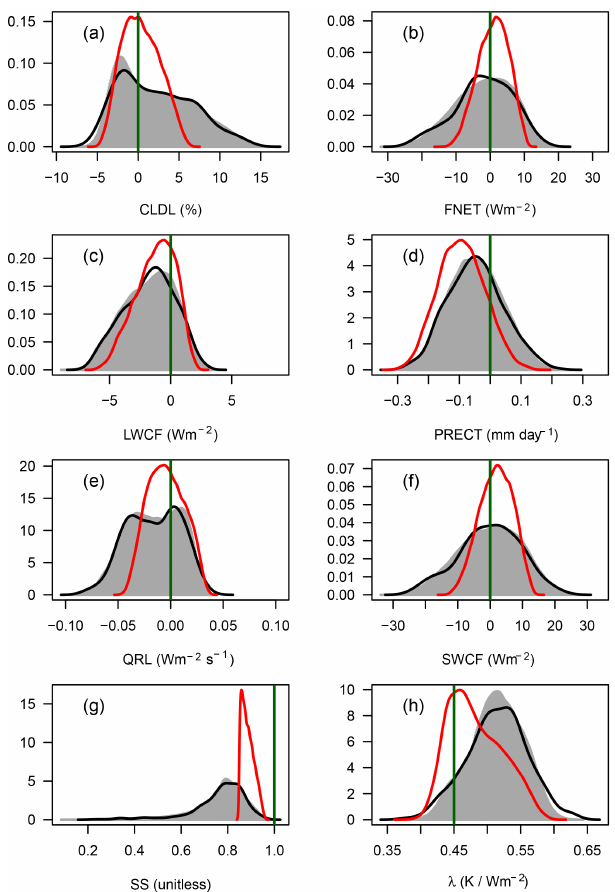
Figure 2. The black line shows the density distribution of sim- ulated values from CAM4 for (a) CLDL, (b) FNET, (c) LWCF, (d) PRECT, (e) QRL, (f) SWCF, (g) multivariate skill score (SS), and (h) Cess climate sensitivity ( λ ), from the n = 350 training cases (variable names are defined in the text). The gray shaded region shows the density distribution from 100000 emulated samples of each variable, and the red line shows the density distribution for the subset of emulated samples that is most plausible (see Sect. 4.3). Note the different x axis scales in each panel. The dark green verti- cal line in each panel indicates the location of CAM4 with its default parameter